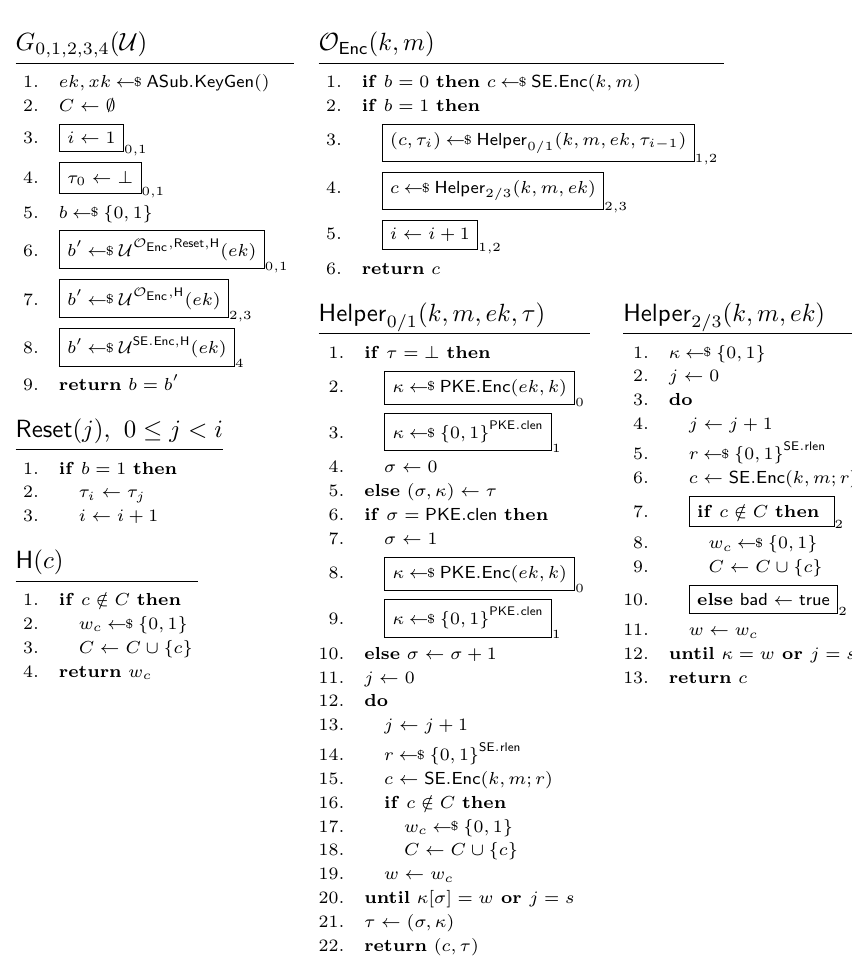
Figure 8: Games G 0 through G 4 for the proof of Theorem 2. For boxed code, only the games indicated in the subscripts contain that